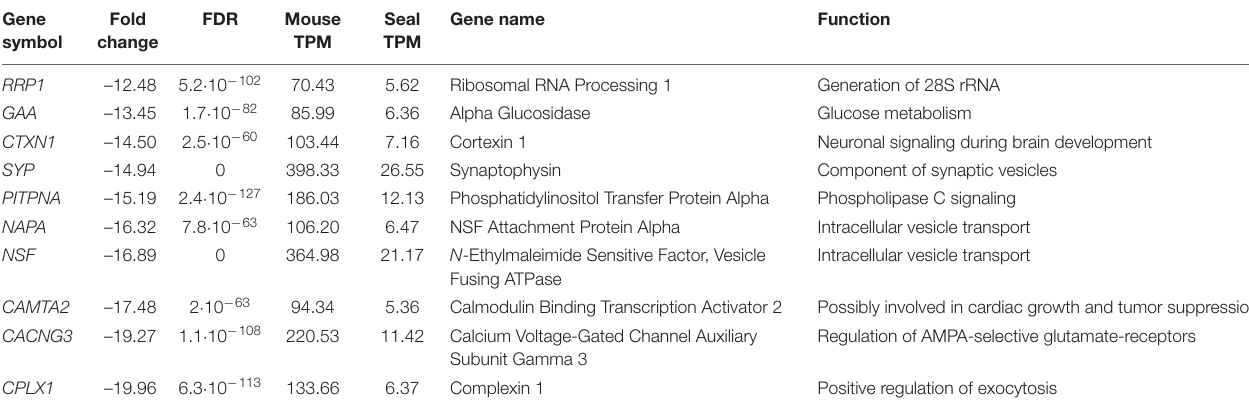
TABLE 2 | Top 10 differentially expressed genes: genes with the most negative fold change in the neurons of the hooded seal visual cortex compared to the mouse. Gene